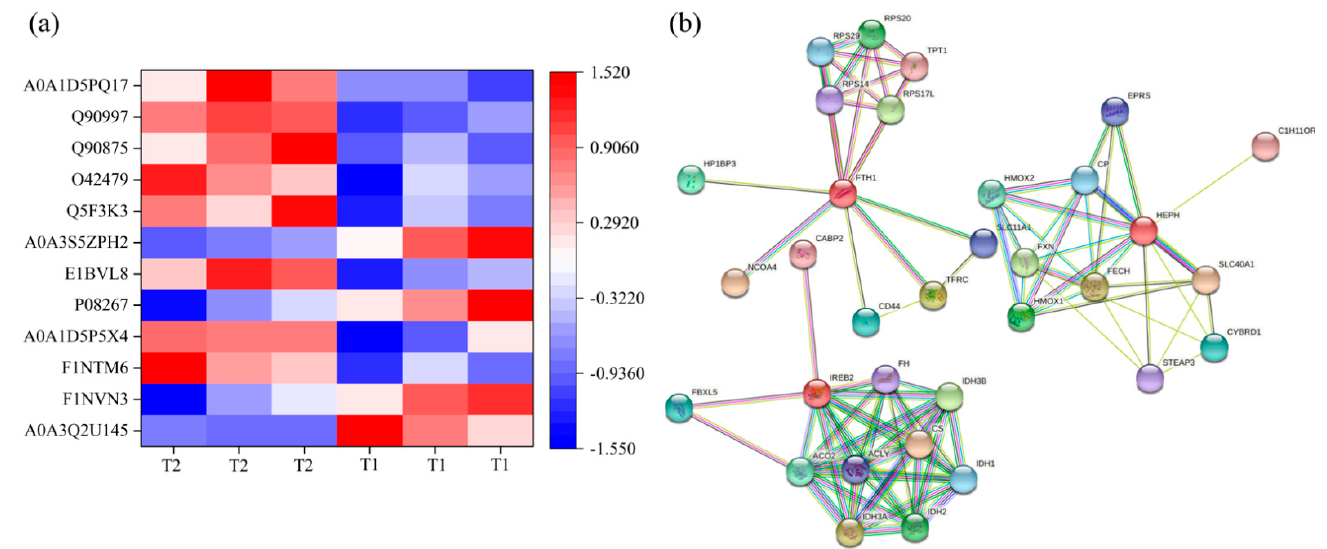
Figure 5. ( a ) Hierarchical clustering of DEPs associated with hepatic iron metabolism. ( b ) Protein- protein interaction network analysis. The color scale bar located in the right, and blue and red indicate decreased and increased levels of the identified proteins, respectively. FTH1: Ferritin, Heavy chain 1, TFRC: Transferrin receptor, SLC11A1: Natural resistance-associated macrophage protein 1, FECH: Ferrochelatase, HEPH: Hephaestin, SLC40A1: Solute carrier family 40 protein, IREB2: Iron responsive element binding protein 2, ACO2: Aconitate hydratase 1, CYBRD1: Cytochrome b reductase 1, STEAP3: Metalloreductase steap3, HMOX 1: Heme oxygenase 1, HMOX 2: Heme oxygenase 2.